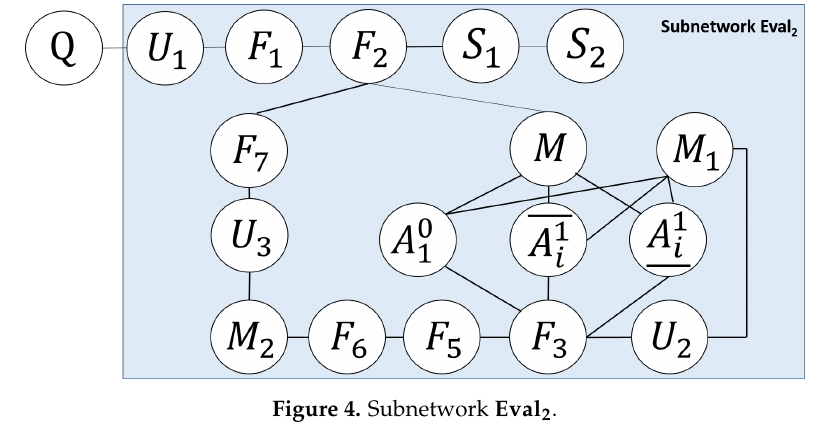
Figure 3. Subnetwork Eval 1 .